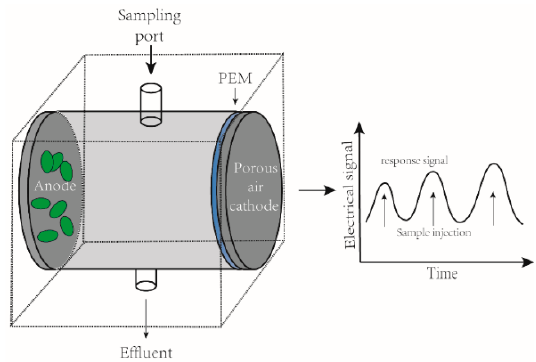
Figure 4. Simplified view of a single-chamber MFC-based BOD biosensor.